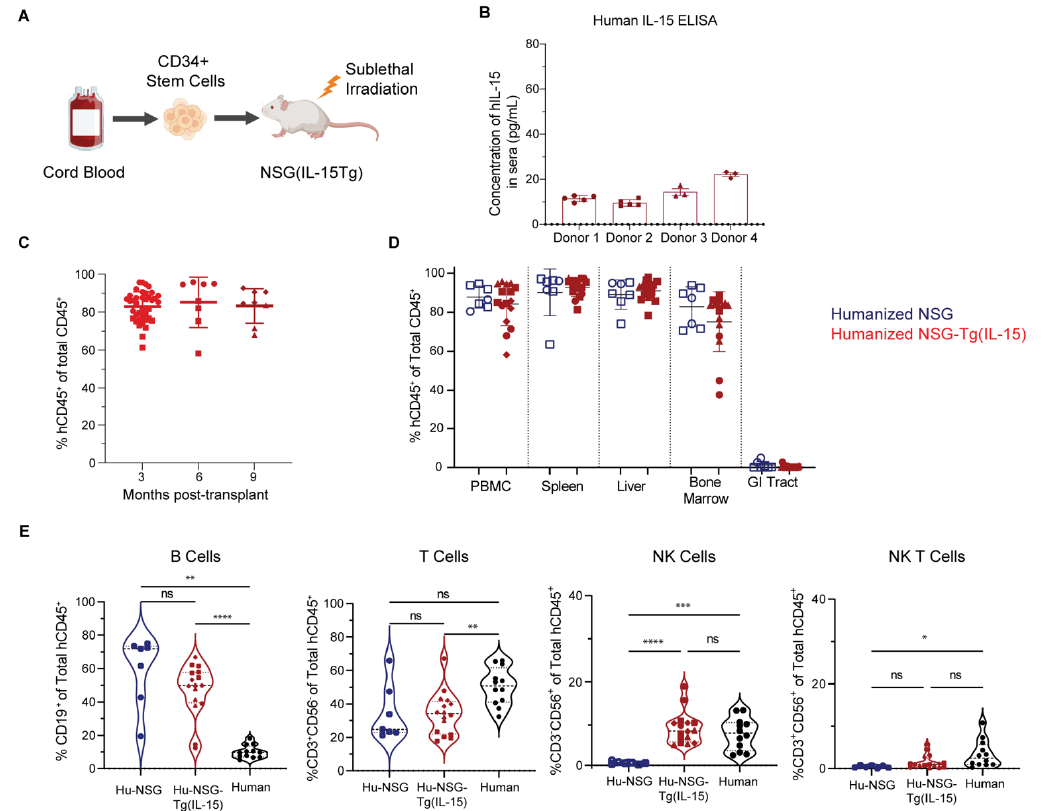
Figure 1. NSG ‐ Tg(IL ‐ 15) mice support the reconstitution of human immune cells for at least 9 months post ‐ transplant with human cord ‐ blood ‐ derived CD34 + HSCs. ( A ) Schematic of humanization of NSG ‐ Tg(IL ‐ 15) mice with cord ‐ blood ‐ derived CD34 + stem cells. Image created with Biorender. ( B ) Concentration of human IL ‐ 15 in sera of humanized NSG ‐ Tg(IL ‐ 15) ( n = 16, 4 unrelated donors). ( C ) Frequency of human immune cells (hCD45 + mCD45 ‐ ) assessed by flow cytometry at 3, 6, and 9 months post ‐ transplant. ( n = 8–20, 2 unrelated donors). ( D ) Frequency of human immune cells (mCD45 ‐ hCD45 + ) in PBMC, spleen, liver, bone marrow, and gastrointestinal tract in humanized NSG ( n = 7, 2 unrelated donors) and humanized NSG ‐ Tg(IL ‐ 15) ( n = 16, 4 unrelated donors) 6 months post ‐ transplant with CD34 + stem cells. ( E ) Frequency of B cells (mCD45 ‐ hCD45 + CD19 + ), T cells (mCD45 ‐ hCD45 + CD3 + CD56 ‐ CD19 ‐ ), NK cells (mCD45 ‐ hCD45 + CD3 ‐ CD56 + CD19 ‐ ), and NK ‐ T cells (mCD45 ‐ hCD45 + CD3 + CD56 + CD19 ‐ ) in PBMCs isolated from humanized NSG mice ( n = 7, 2 unre ‐ lated donors), humanized NSG ‐ Tg(IL ‐ 15) mice ( n = 16, 4 unrelated donors) 6–9 months post CD34 + HSC transplant, and healthy human donors ( n = 12). Mice were injected with 50,000 CD34+ human HSC at 6 weeks of age. Statistical significance was calculated using an unpaired t ‐ test for 2 groups or one ‐ way ANOVA or Brown–Forsythe test for 3 groups. Mice reconstituted from unrelated hu ‐ man donor cord ‐ blood ‐ derived CD34 + stem cells are denoted by different symbols. ns = not signifi ‐ cant, * p < 0.05, ** p < 0.01, *** p < 0.005, and **** p < 0.0001.